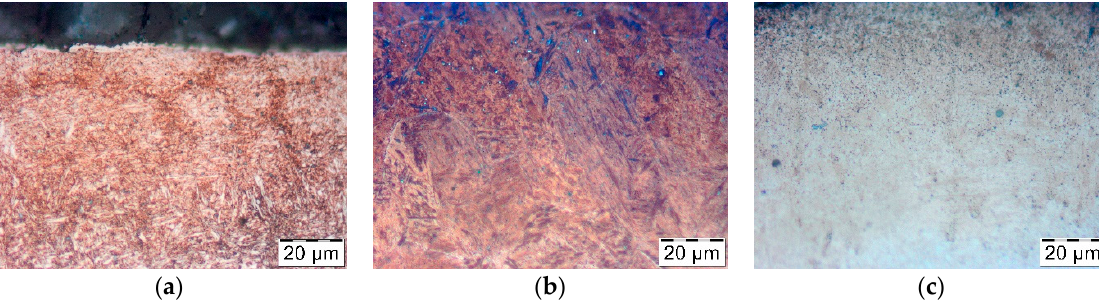
Figure 10. The microstructure of the nitrided layer: ( a ) as delivered; ( b ) held at 675 °C for 2 h; ( c ) after 3000 forging cycles at approximately 666.1 °C.